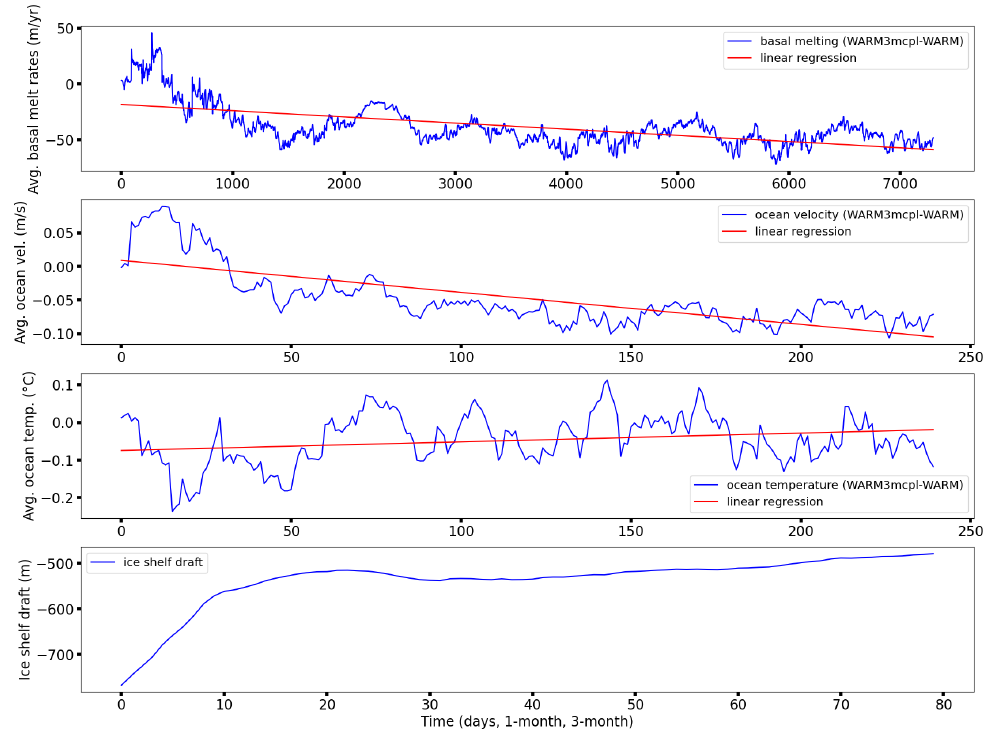
Figure A8. Time series of the difference in basal melt rate, ocean current speed, ocean temperature and ice shelf draft over the 20-year period in WARM and WARM3mcpl. All time series are averaged where the mean basal melt rate is higher than 50 m year − 1 in the center of the TIS